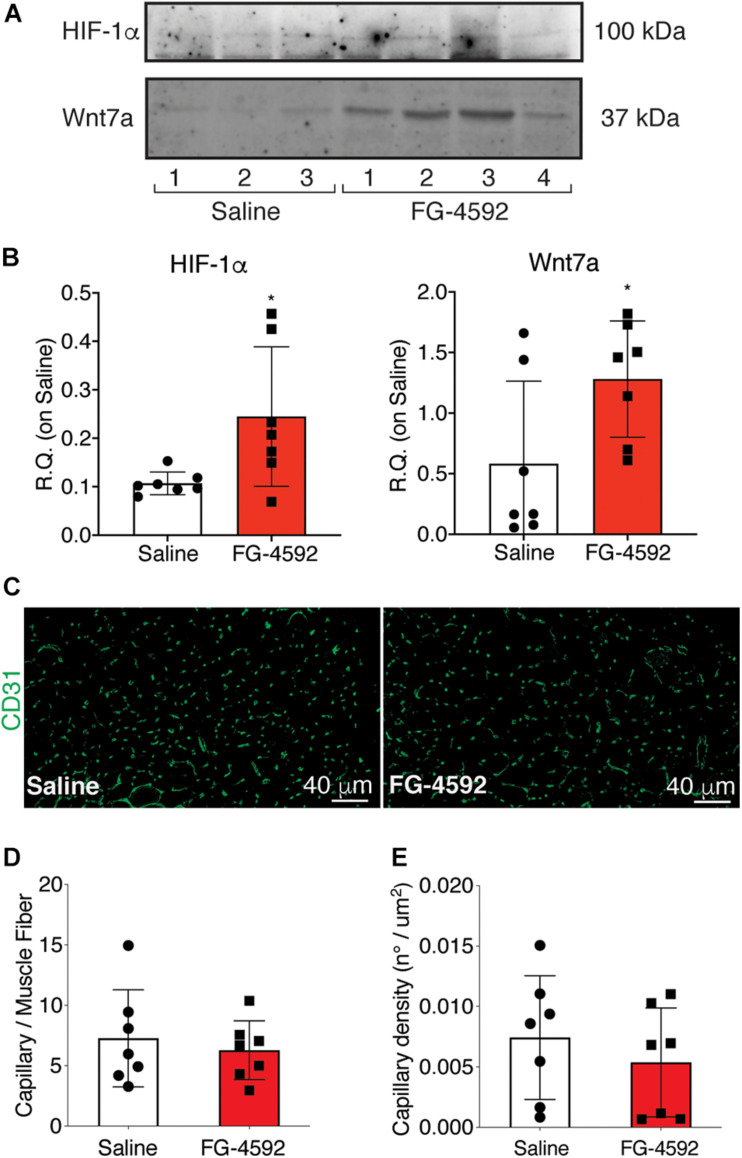
Assessment of activation of hypoxia inducible factor-1α (HIF-1α) pathway in FG-4,592 or saline treated mice upon cardiotoxin CTX-induced muscle injury. (A,B) Western blot analysis (A) and relative quantification (B) of HIF-1α and Wnt7a accumulation in saline and FG-4592 pre-treated mice 7 days after CTX-induced muscle injury (n = 7). (C) Immunofluorescence staining of CD31 (green) on tibial anterior muscle sections of saline and FG-4592 pre-treated mice 7 days after CTX-induced muscle injury (Scale bars = 40 μM). (D and E) Quantification of the total number of capillaries (D), normalized for the total number of muscle fibers, and the density of capillaries (E), calculated as the total number of capillaries on the area of the fibers, in saline or FG-4592 pre-treated mice (n = 7 for each group). Data information: all data represent mean ± SD. p > 0.05, n.s., *p < 0.05 (Student’s t-test).